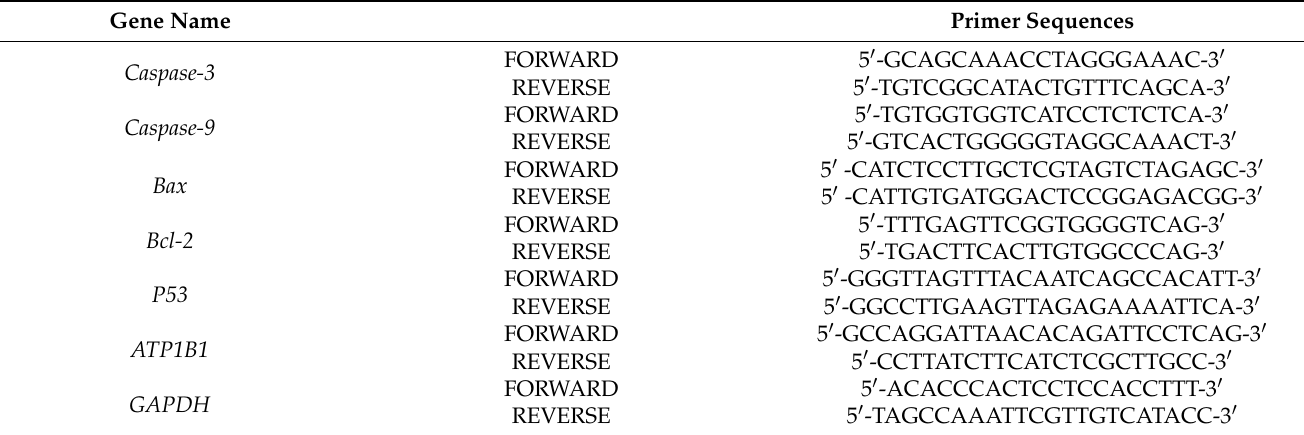
Table 1. Oligonucleotide primers used in this